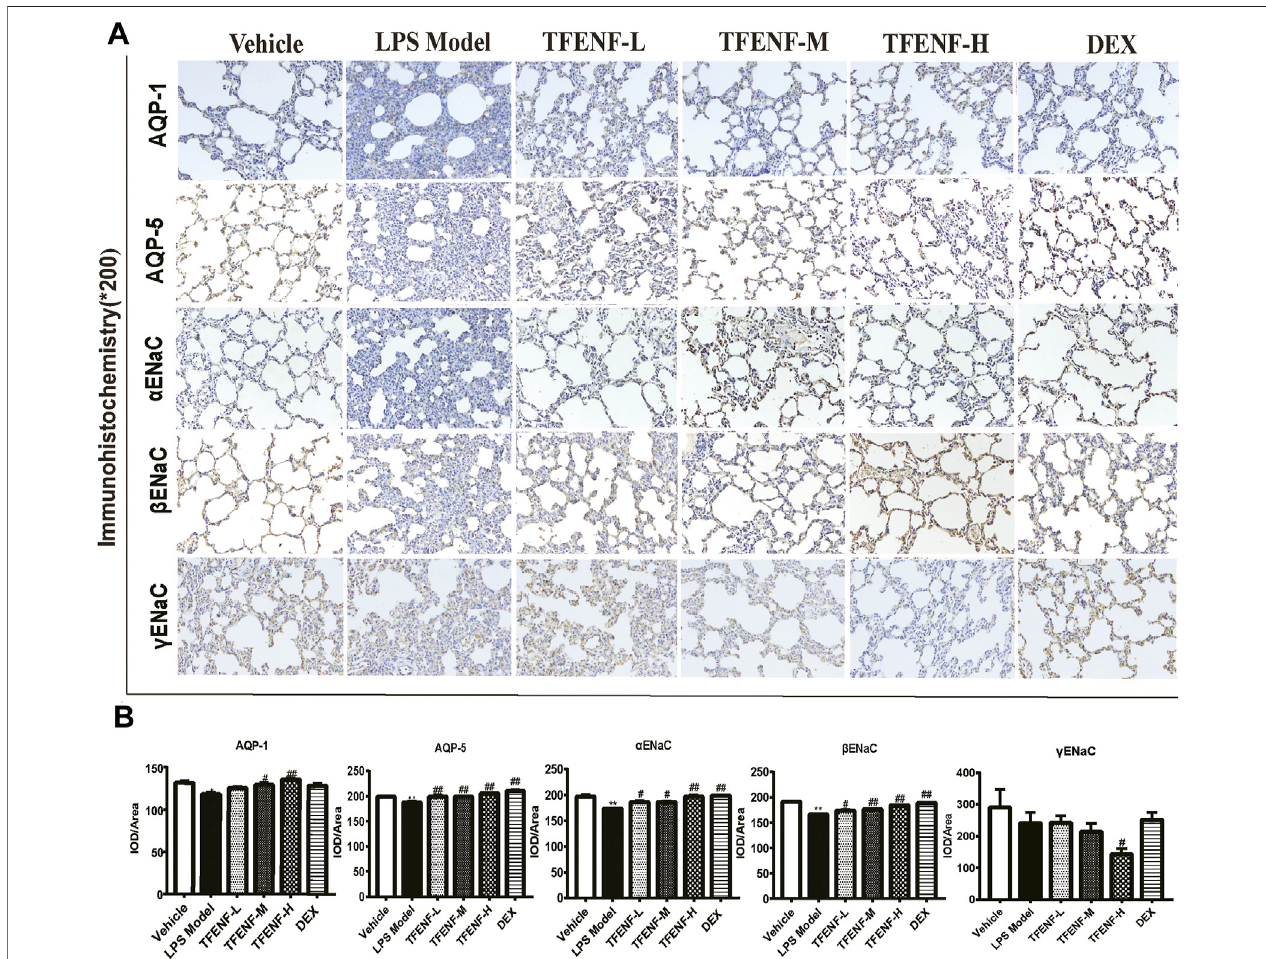
FIGURE7| TFENFpromotedtheproteinexpressionof AQPs andENaCsinLPS-inducedALI.EffectofTFENFontheproteinexpressionof AQP-1,AQP-5 , α ENaC, β ENaC , and γ ENaCinratlungtissue6 hafterLPS-inducedALIorsalinetreatment( n (cid:2) 6pergroup)(immunohistochemistrystaining,magni fi cation × 200).Representativephotographsof immunohistochemistry assay (A) and quantitative analysis of immunohistochemistry results (B) . Data are presented as mean ± S.E.M. The numbers of cells expressing AQP-1, AQP-5, α ENaC ,and β ENaC aresigni fi cantlydecreasedinLPS-inducedALIcomparedwiththoseinthevehiclegroup.Meanwhile,thenumbersofcellsexpressing AQP-1 , AQP-5 , α ENaC , and β ENaC are signi fi cantly increased after TFENF treatment. Brown immunostained cells are positive. *p < 0.05 compared with the vehicle group; **p < 0.01 compared with the vehicle group; # p < 0.05 compared with the LPS model group; ## p < 0.01 compared with the LPS model group.